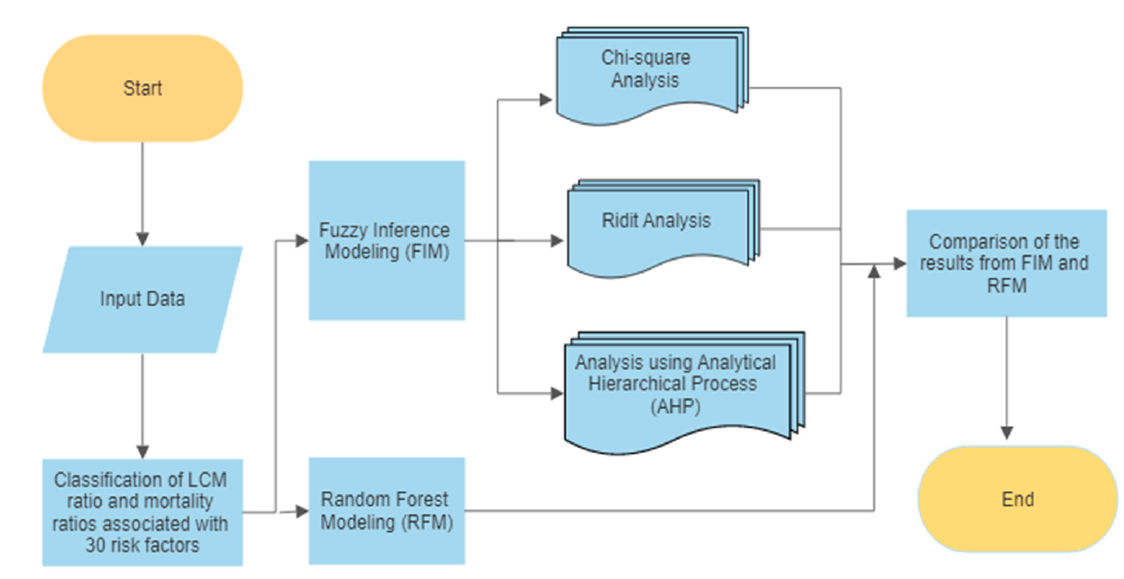
Figure 2. Analysis framework.